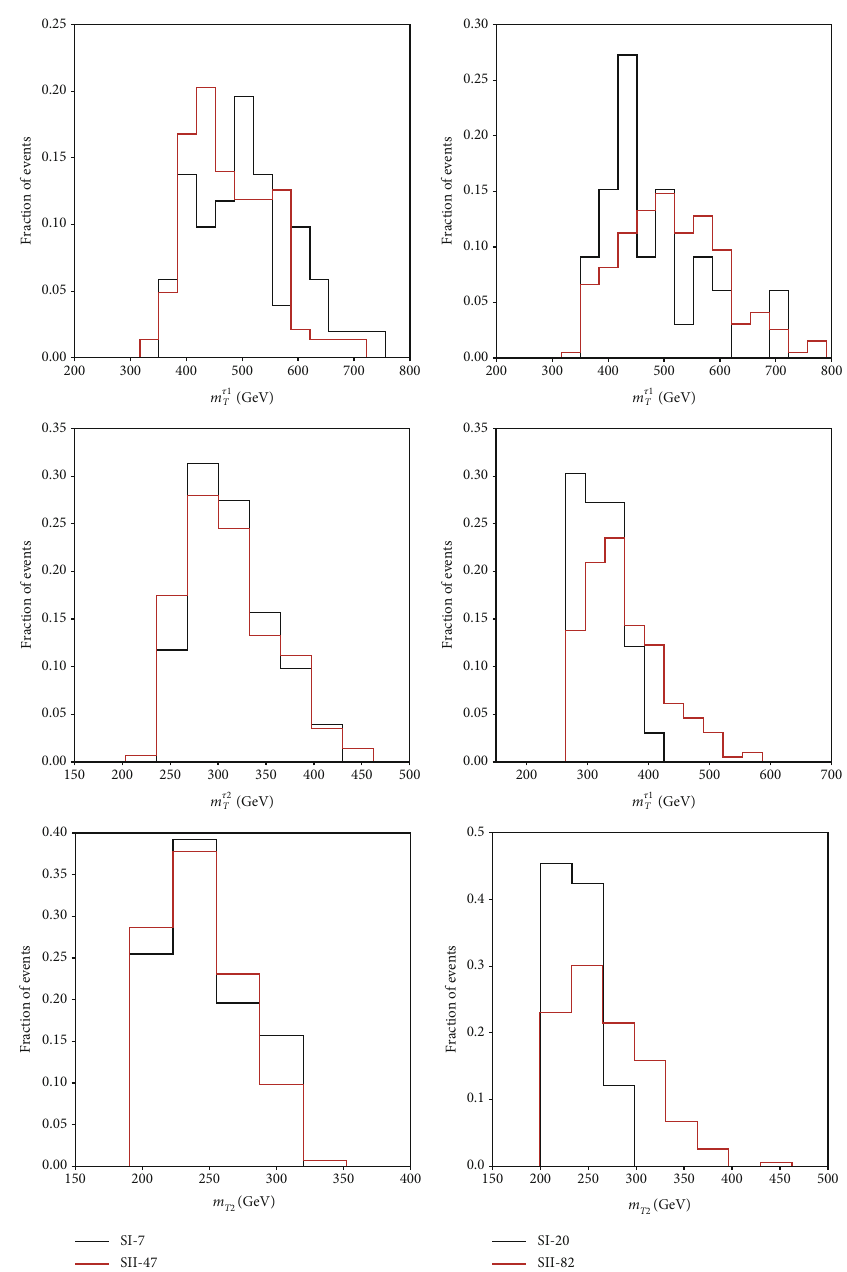
τ , m , and m (a – f) after applying the cuts listed in Table 3 for benchmarks SI-7 and 2 T 2 T T